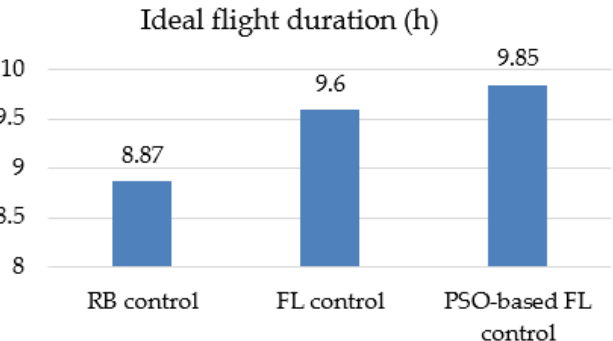
Figure 20. The histogram of the ideal flight duration according to three strategies.